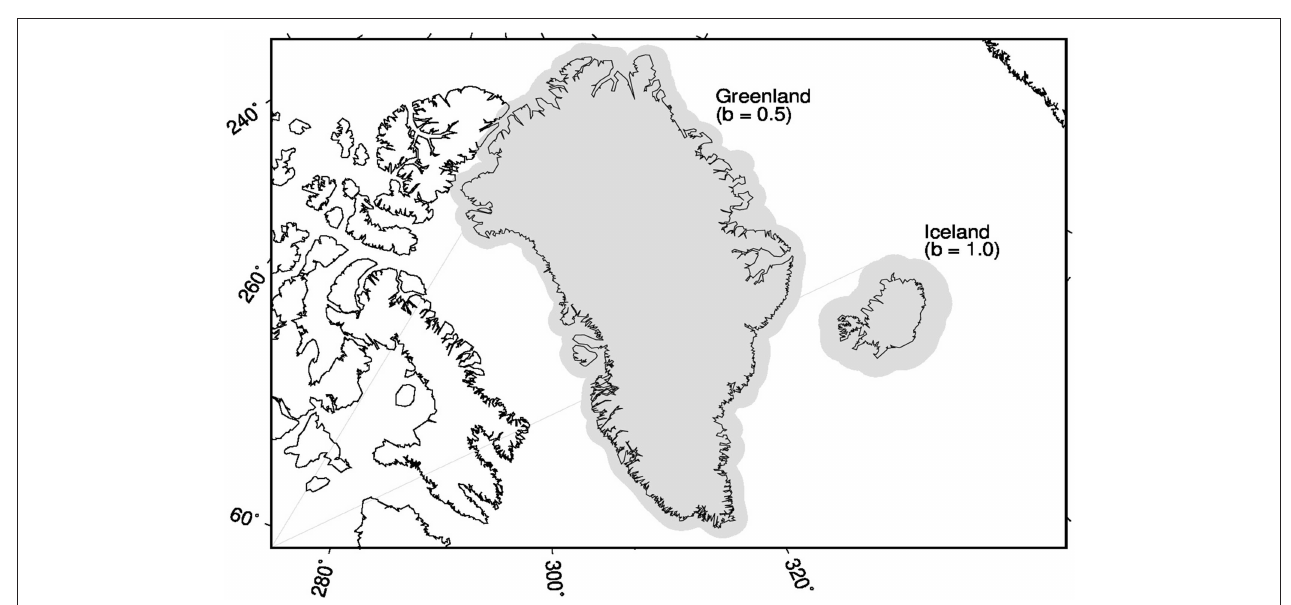
FIGURE 1 | A map of the localization regions used for Greenland and Iceland. b denotes buffer. The gray areas represent the region of Greenland buffered by 0.5 ◦ and the region of Iceland buffered by 1.0 ◦ , respectively. We use an oblique Mercator projection centered in Greenland.